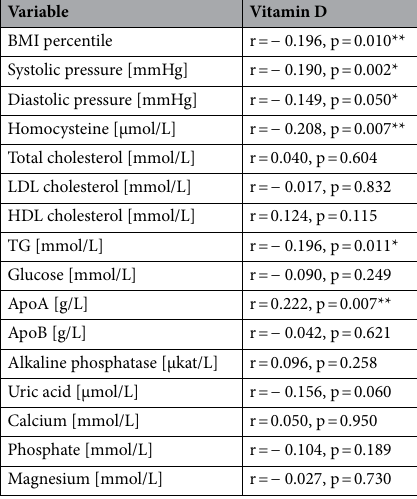
Table 4. Correlation between vitamin D levels and different parameters in all of the observed groups with the use of Pearson’s correlation coefficient. BMI Percentile body mass index percentile, LDL cholesterol low- density lipoprotein cholesterol, HDL cholesterol high-density lipoprotein cholesterol, TG triglycerides, ApoA apolipoprotein A1, ApoB apolipoprotein B. *p < 0.05, **p <